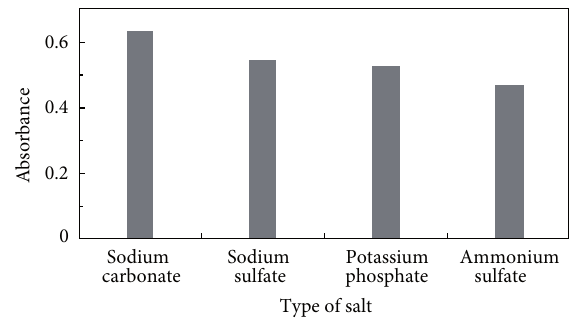
F 3: Effect of type of PEG on the extraction efficiency. Exper- imental conditions: volume of buffer; 9mL, pH of sample; 5.5, amount of PEG; 4gr, amount of sodium carbonate; 2.5gr, tempera-